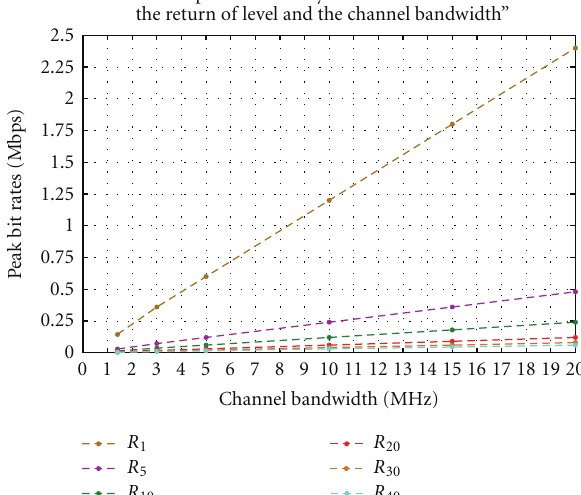
Figure 6: Peak data rates of a SU cotransmitting opportunistically along with a PU in an LTE